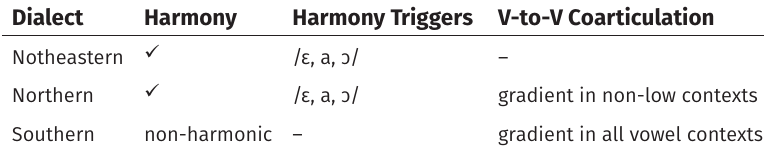
Table 7: The behavior of pretonic /e, o/ in the three